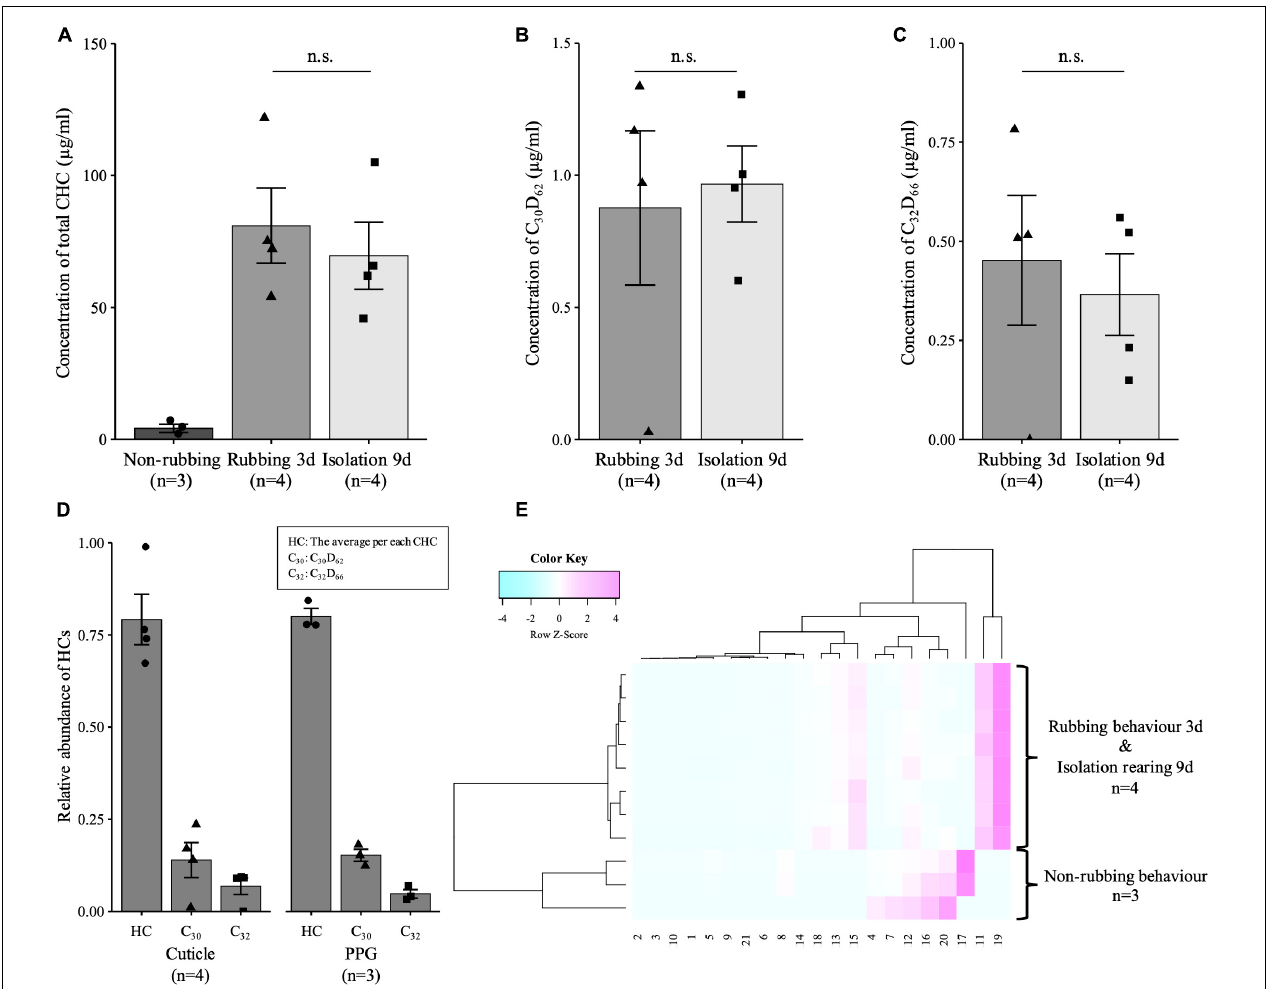
FIGURE 3 | Comparison of CHC and labeled substances in the newly mated P. lamellidens queens. These experiments used C. japonicus as a host worker (A–E) . (A) The concentration of CHC in the newly mated P. lamellidens queens [Mann–Whitney U test, n.s., non-significant difference (the actual value: 0.485), n = 4]. (B,C) The concentration of labeled substances ( n -triacontane-d62: C 30 D 62 , n -dotriacontane-d66: C 32 D 66 ) in newly mated P. lamellidens queens [Mann–Whitney U test, n.s., non-significant difference (the actual value: 0.885–1.000), n = 4]. (D) The ratio of hydrocarbons (the average per CHC, C 30 D 62 , C 32 D 66 ) on the newly mated P. lamellidens queen cuticle and postpharyngeal glands (PPG) after rubbing behavior. The average ratios of hydrocarbons identified in the cuticle and postpharyngeal glands were correlated [Pearson method, R = 1, p -value < 0.01 (the actual value: 0.000)]. (E) Hierarchical clustering analysis of the CHCs of newly mated P. lamellidens queens. This analysis was performed using the peak area value that was converted to a Z score. The number on the X -axis indicates the type of estimated hydrocarbon (see Supplementary Table 2 ). All error bars indicate the standard